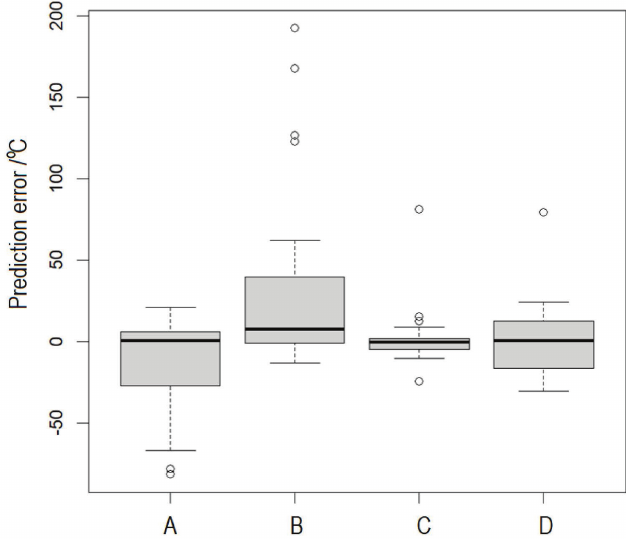
Fig. 5 – Box plots of the errors in predictions of the eutectic temperatures by A) ideal solution model, B) COnductor like Screening MOdel for Real Solvents (COSMO-RS), C) structural causal model with molecular descriptors (SCM-MD), and D) structural causal model with molecular fingerprints